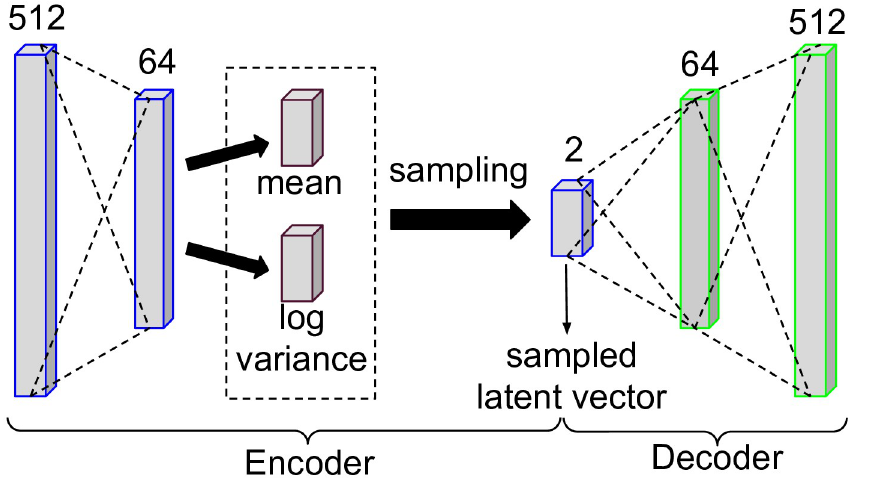
Fig 3. Variational autoencoder